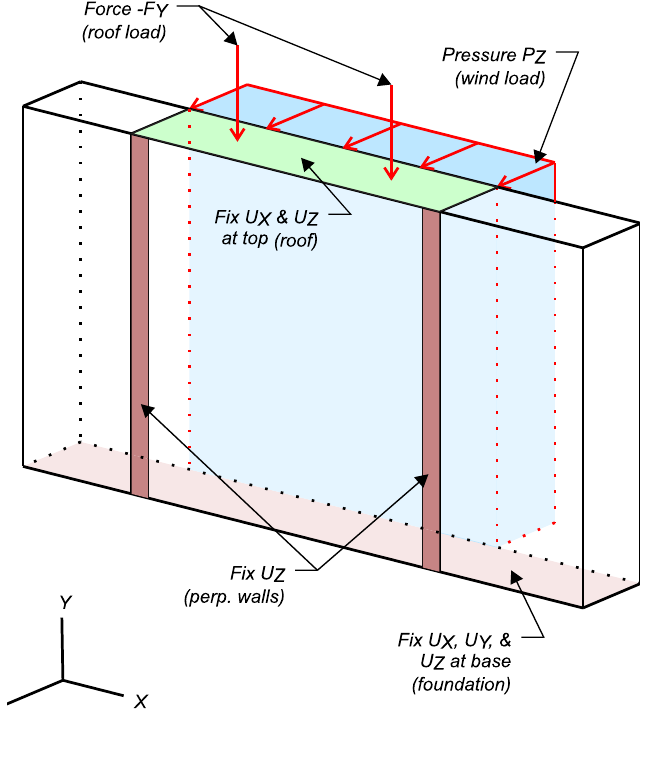
Figure 3. Test wall boundary and loading